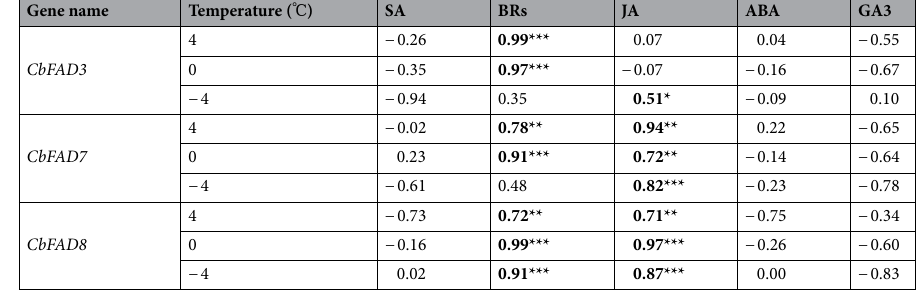
Table 1. Pearson correlation coefficients (two-tailed) between the cold-responsive and the hormone-regulated expressions of ω-3 CbFAD genes in C. bungeana cells. Three replications for each sample, n = 5 × 3. Significant positive correlation ( R > 0.50, P < 0.05) is indicated in bold. * P < 0.05, ** P < 0.01, *** P < 0.001.